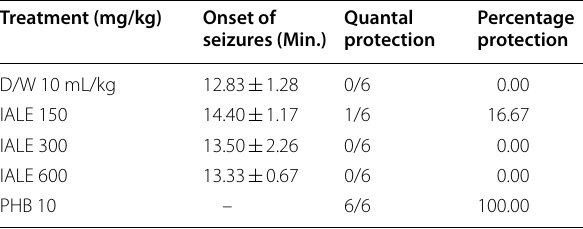
Data are presented as Mean S.E.M., No statistically significant differences ± among mice groups—One-way ANOVA followed by Dunnett’s post hoc test, n 6, D/W Distilled water, IALE Ipomoea asarifolia leaf extract, = = = PHB Phenobarbitone = Table 7 Effect of Ipomoea asarifolia ethanolic leaf extract on 4-aminopyridine-induced seizures in mice Treatment (mg/kg) Onset of seizures